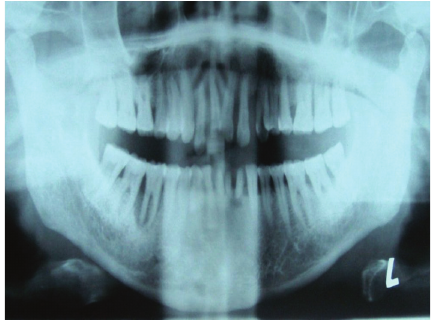
Figure 2: Orthopantomography revealed generalized bone loss.